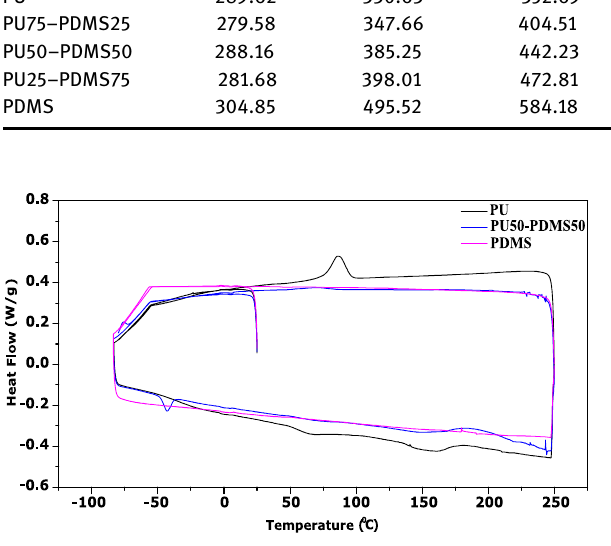
Figure 13: DSC measurement of PU – PDMS polymers.